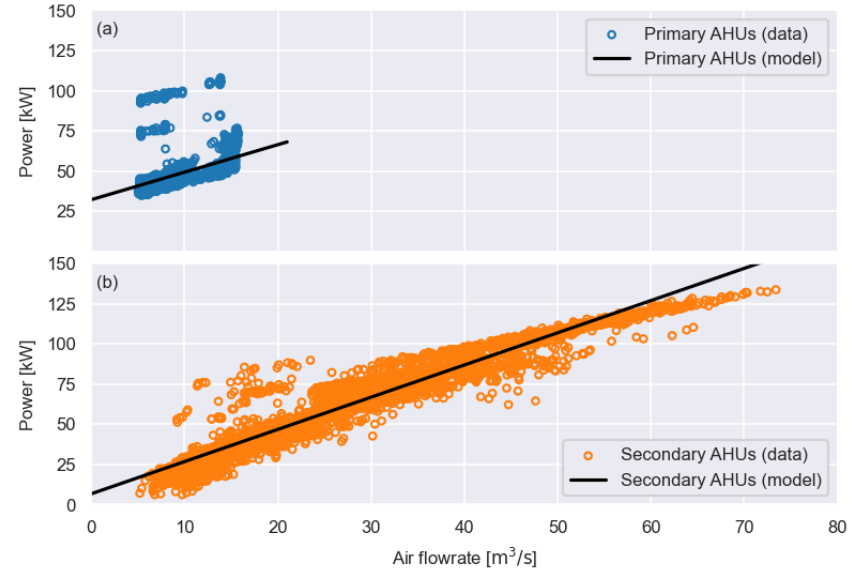
Figure 8. ( a ) Primary AHU fan power as a function of fresh air flowrate; ( b ) secondary AHU fan power as a function of discharged air flowrate.